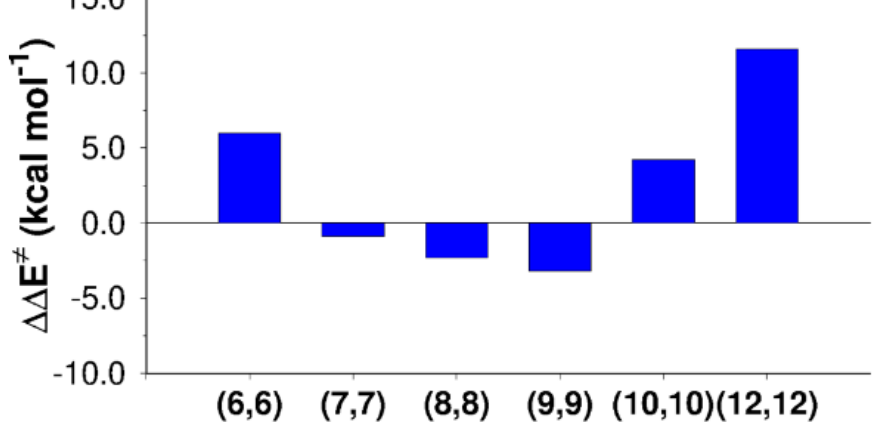
Figure 3. Activation energy variations ∆∆ E ‡ with respect to the gas-phase value ( ∆ E ‡ ) of the S N 2 reaction mechanism computed inside CNTs of different diameters.